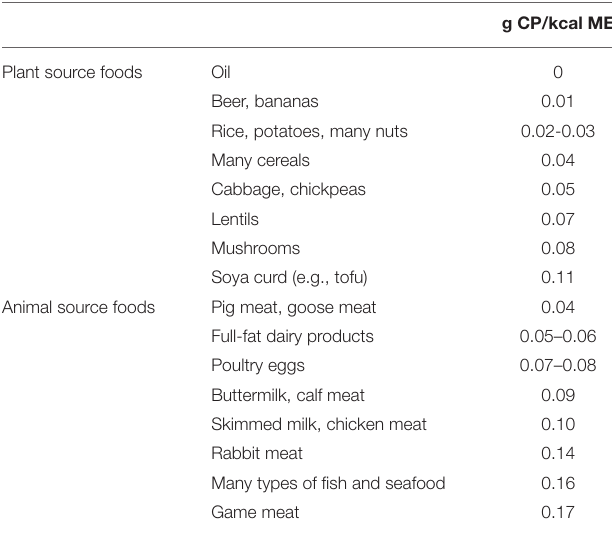
TABLE 1 | Crude protein to metabolizable energy ratio in various food commodities, from FAO (2001, Annex I).